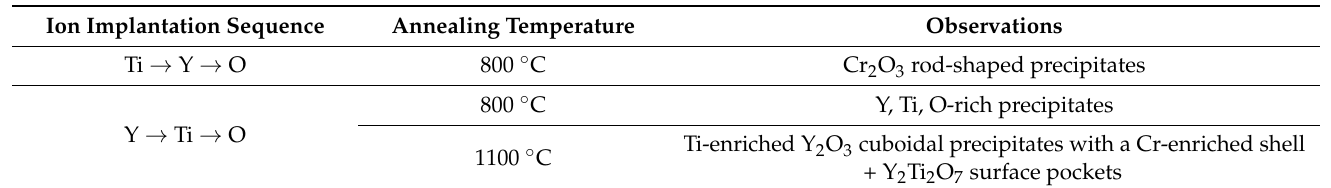
Table 1. Summary of ion beam synthesis conditions and corresponding